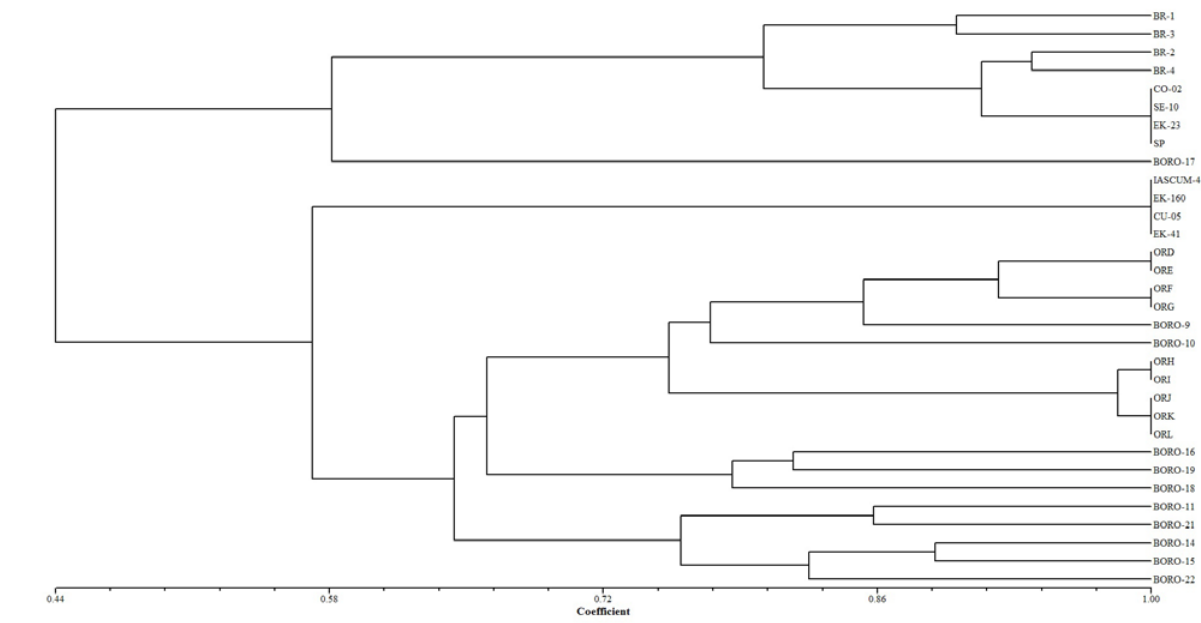
Figure 2. Tree plot of the nine broomrape populations studied (ORD through ORL), together with eight reference popula - tions from the Guadalquivir Valley in Southern Spain classified as race F (populations CO-02, SE-10, EK-23, and SP) and race G (BR-24, BR-25, BR-27, and BR-28), four populations from Central Spain (IASCum-4, CU-05, CU-07, CU-12), one from Serbia (Boro-9), one from Romania (Boro-10), one from Israel (Boro-11), two from Turkey (Boro-14, Boro-15), and six populations from Bulgaria (Boro-16 to Boro-19, Boro-21, and